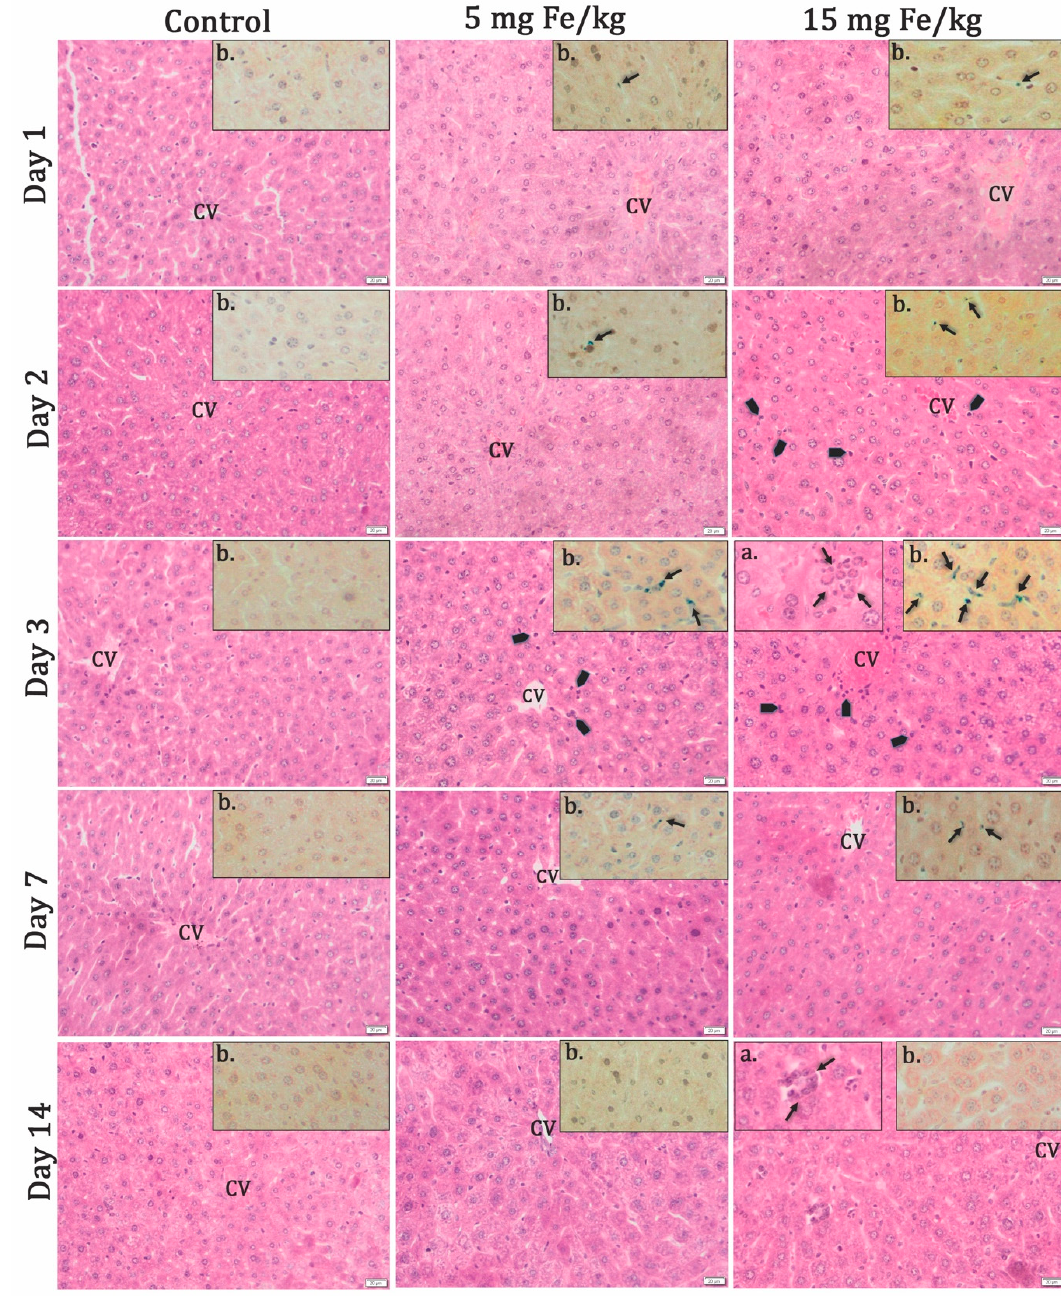
Figure 2. The histopathological aspect of the liver tissues at 1, 2, 3, and 7 d of MNP-DSPE-PEG injection. Hematoxilin&Eosin staining; CV—centrilobular vein; arrowhead—inflammatory cells; ( a ) detail rectangles—granulomas with giant cells; ( b ) detail rectangles—Prussian blue staining of the presence of iron deposits (blue color indicated by arrows) in the pathological tissue slides after 1, 2, 3, and 7 d post-MNP injection. Scale bar: 20 µm.